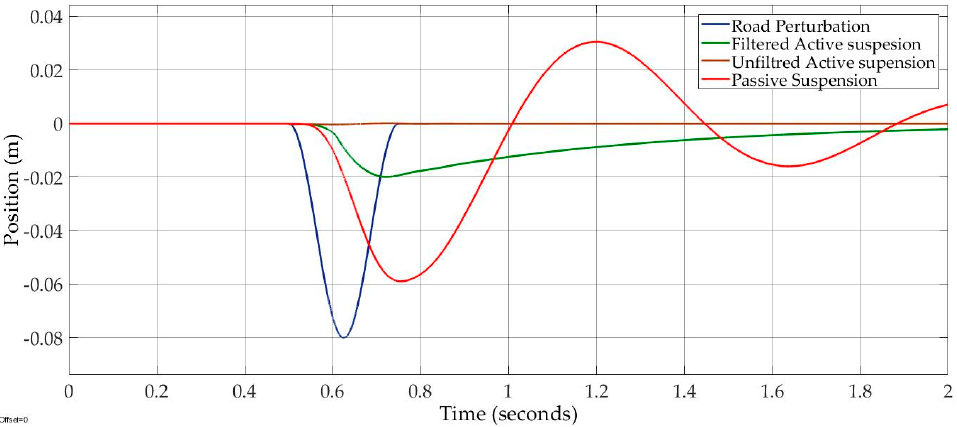
Figure 16. Sprung mass position of Case 4.